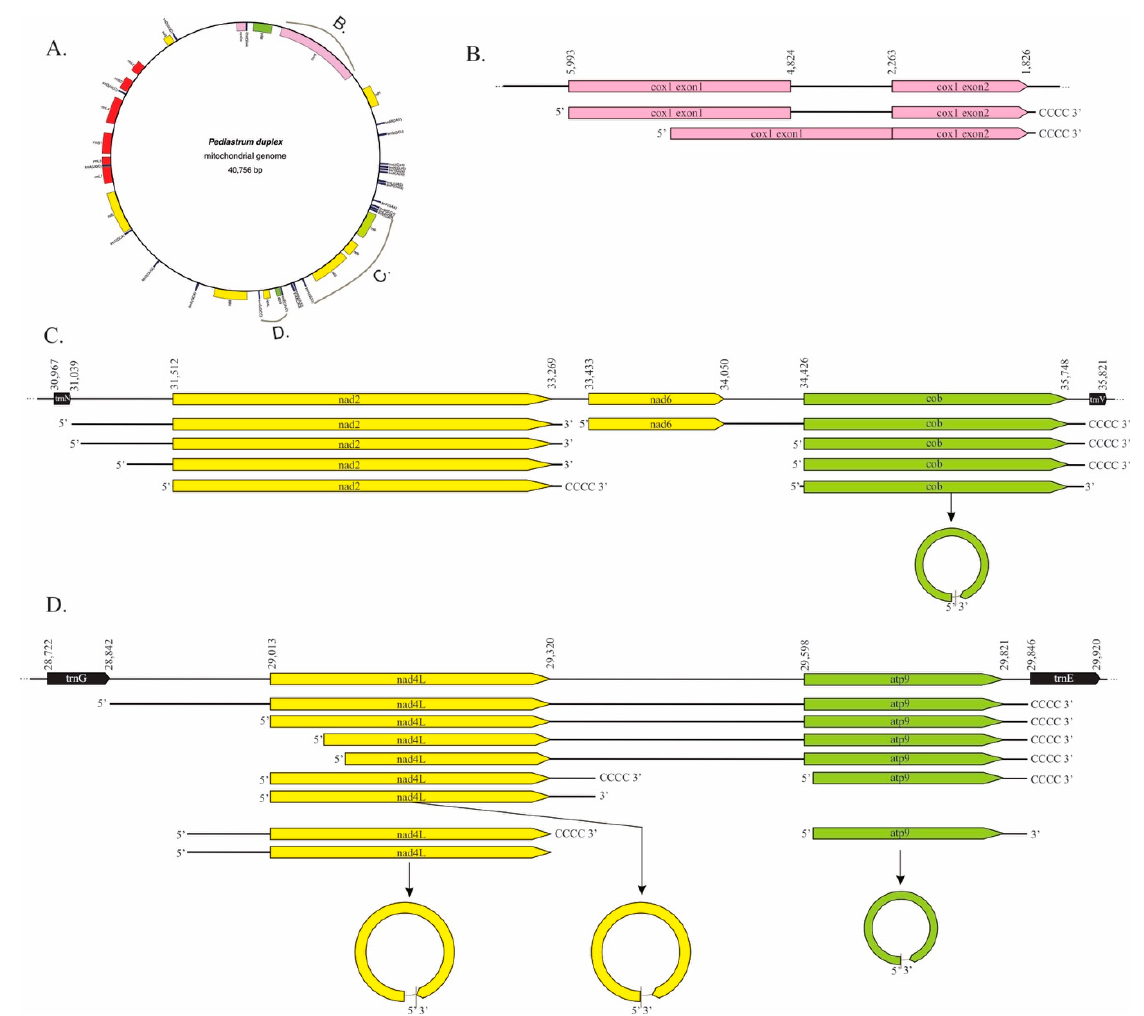
Figure 4. Mitochondrial RNA processing as determined by PacBio Iso-Seq and circRT-PCR. ( A ). The mitochondrial genome of P. duplex (GenBank MK895949). The regions highlighted in portions B, C, and D of this figure are marked. The map was generated using OGDRAW [64]. ( B ). The cox1 gene, the upper diagram represents a portion of the chondriome, the lower two portions represent partially and fully processed transcripts. ( C ). The trnG-nad2-nad6-cob-trnE portion of the chondriome. ( D ). The trnG-nad4L-atp9-trnE portion of the chondriome. Table 3. Site of 5 ′ UTR terminus upstream from start codon (in nucleotides) in Chara vulgaris mito- chondria, nd = no data. * 5 ′ UTR termini detected in this study occur downstream of the start co- dons found in archived chondriomes. The distances presented in this table are marked from the next available AUG start codon.